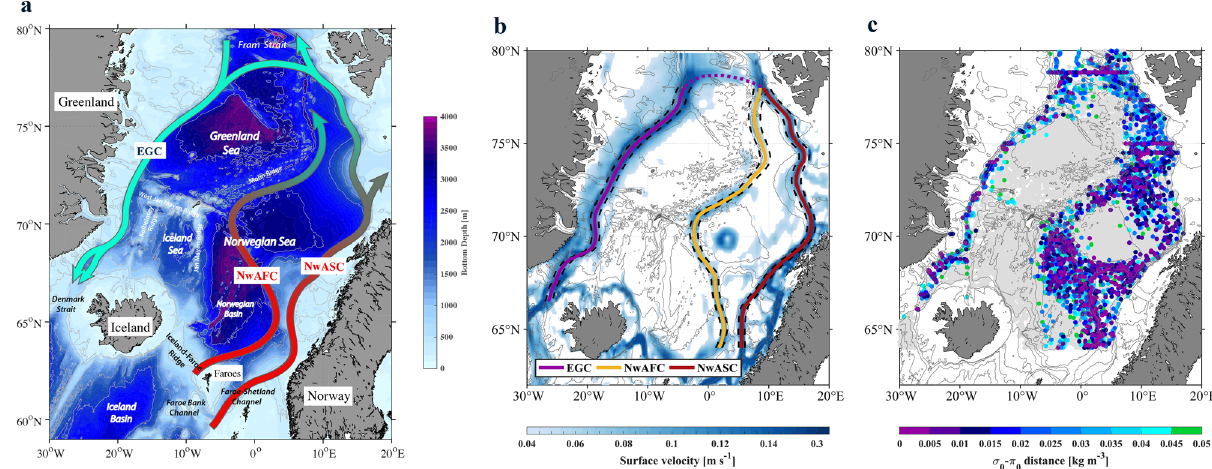
Fig. 1 | Pathways of Atlantic Water along the rim current system in the Nordic Seas. a Schematic circulation, modi fi ed from ref. 40 . The rim current system includes three boundary currents: the Norwegian Atlantic Slope Current (NwASC), the Norwegian Atlantic Front Current (NwAFC), and the East Greenland Current (EGC). b Composite of the long-term mean (2005 – 2018) sea surface velocity (absolutespeed)fromsatelliteobservationsandtheGLORYS12reanalysisproduct. Thepathwaysofthethreeboundarycurrentsin( b )weredeterminedbymaximain the surface velocity fi eld, shown by the solid lines. The black dashed lines denote